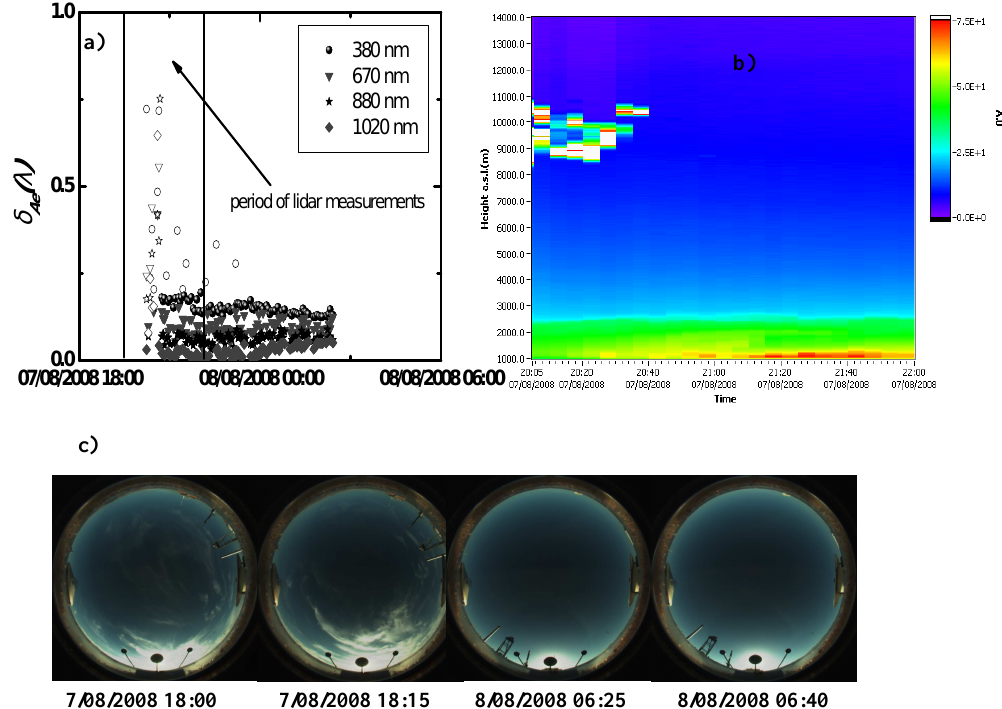
Fig. 6. (a) Temporal evolution of the aerosol optical depth at 380, 670, 880 and 1020nm during the night 7–8 August 2007. Empty symbols correspond to cloud-affected data and full symbols are cloud-free data. (b) Range corrected signal measured by lidar system at 532nm on 7 August 2008 between 20:00 and 22:00UTC. (c) All-sky images during late 7 and early 8 July 2008 (times expressed in